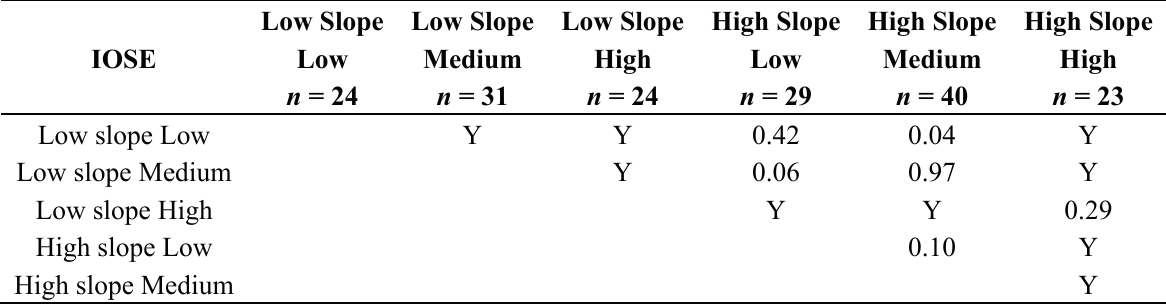
Table 3. p values from pair-wise t -tests of migration speeds of IOSE cells at low, medium, and high concentration regions of the low and high slope LN gradients. n = number of cells used in the analysis. “Y” corresponds to p < 0.05.